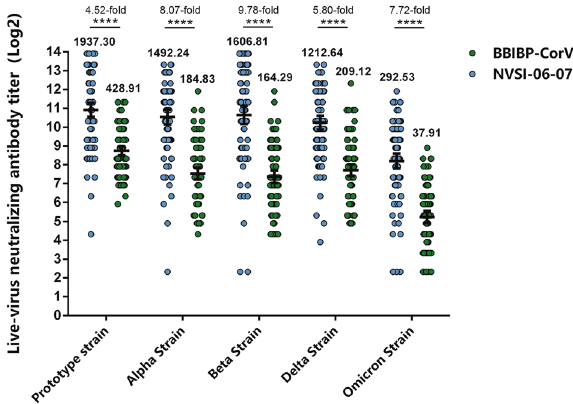
Fig. 2 Cross-reactivity of neutralizing antibody responses against SARS-CoV-2 prototype strain and main VOCs, including Alpha, Beta, Delta and Omicron, elicited by heterologous NVSI-06-07 booster, compared with those elicited by homologous BBIBP-CorV booster. The live-virus neutralizing antibody titers were detected on day 14 post-boost. Serum samples of 192 (half boosted with homologous vaccination and the other half boosted with heterologous vaccina- tion) participants with sequential enrollment numbers in ≥ 6-month boosting-interval group were tested. Both neutralizing antibody GMTs and the ratio of neutralizing GMTs between heterologous and homologous boosters are provided in the fi gure. Data are presented as GMT and 95% CI. **** P <